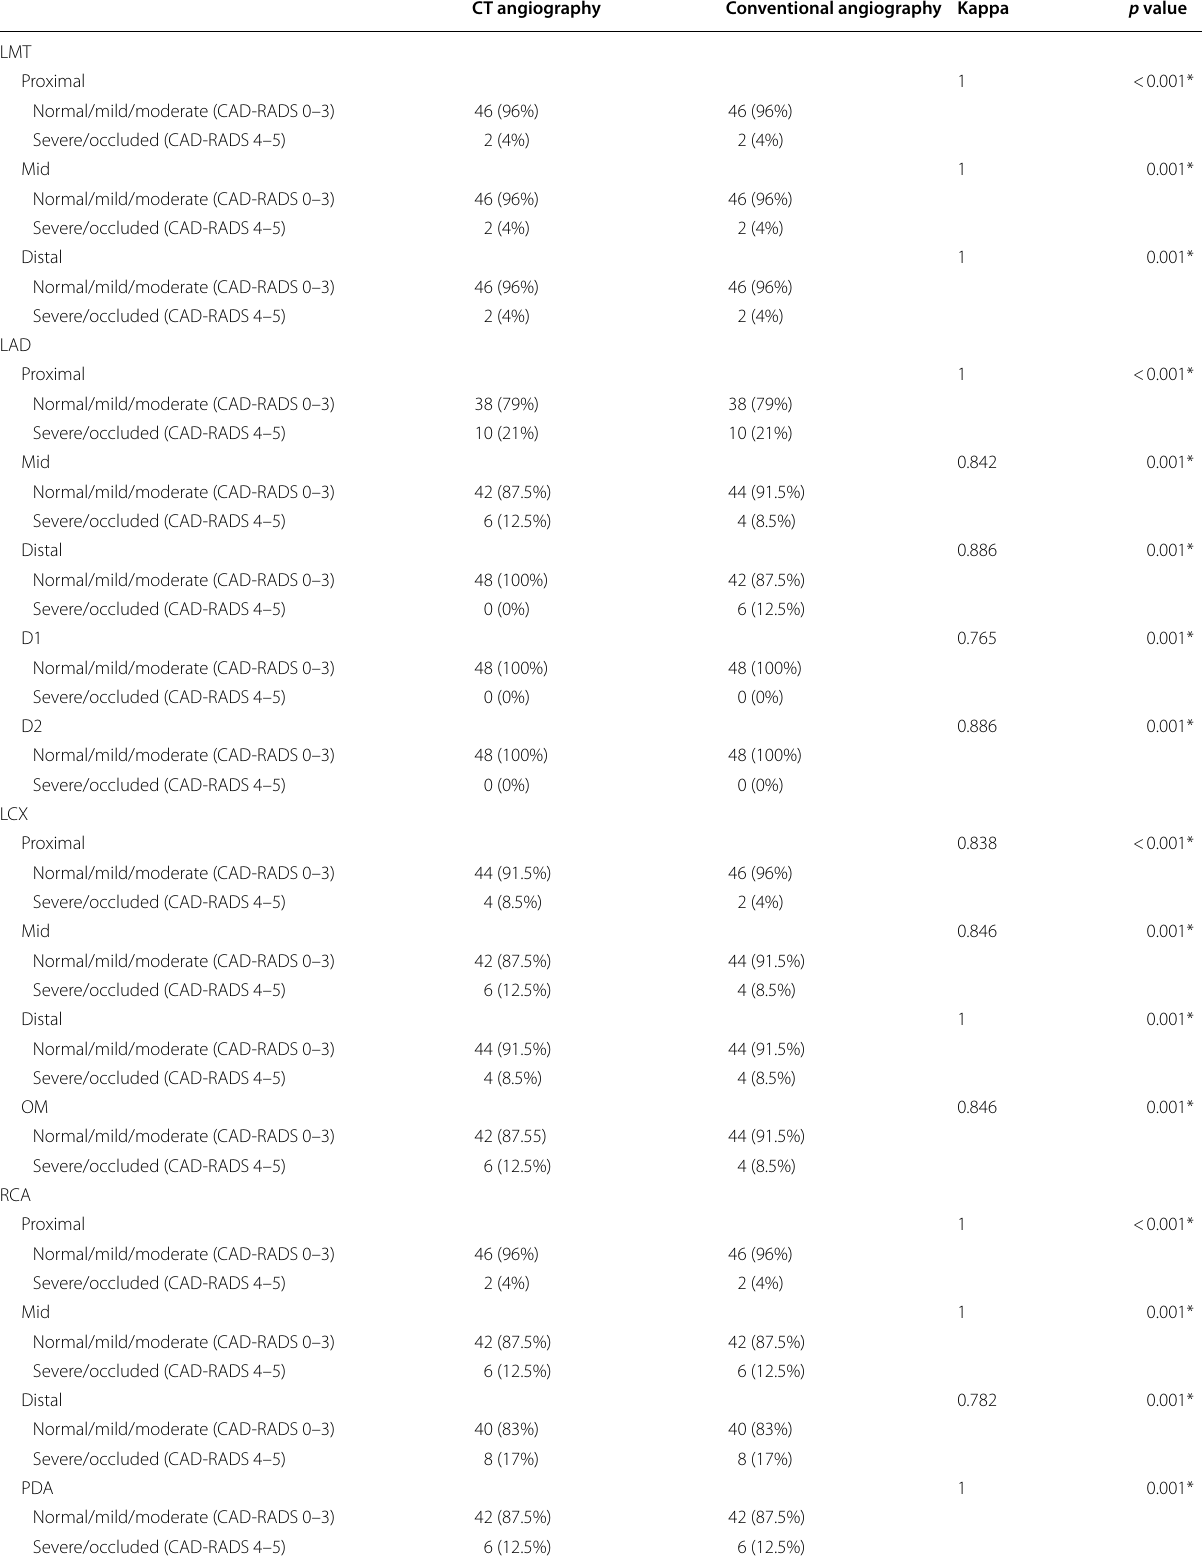
Table 2 Analysis of the coronary vessels findings by the conventional and CT angiography CT angiography Conventional angiography Kappa p value